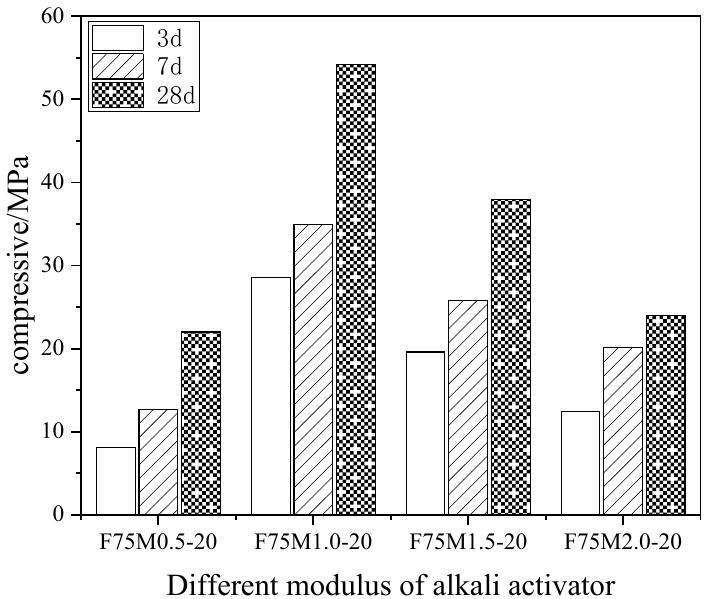
Figure 3. The effect of the different alkali activators modulus on the compressive strength of the geopolymer.